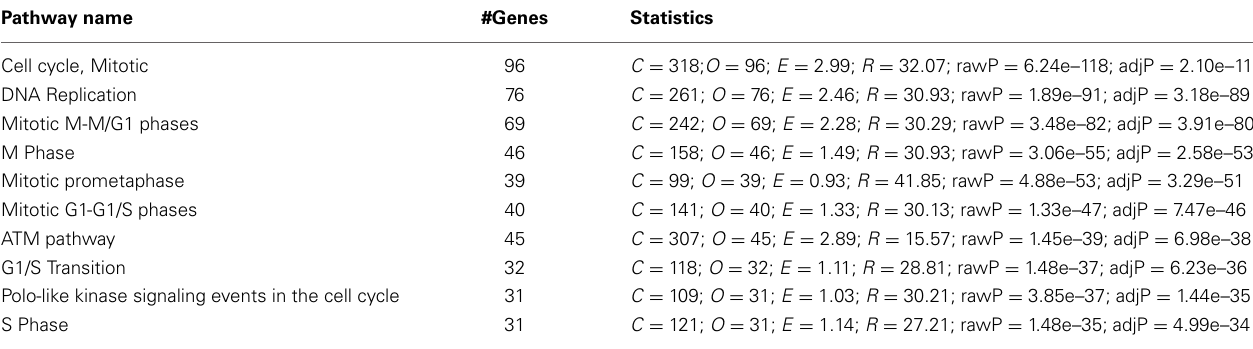
Table 1 | Pathway enrichment analysis of genes highly enriched in the ventricular and subventricular zone during early human development using